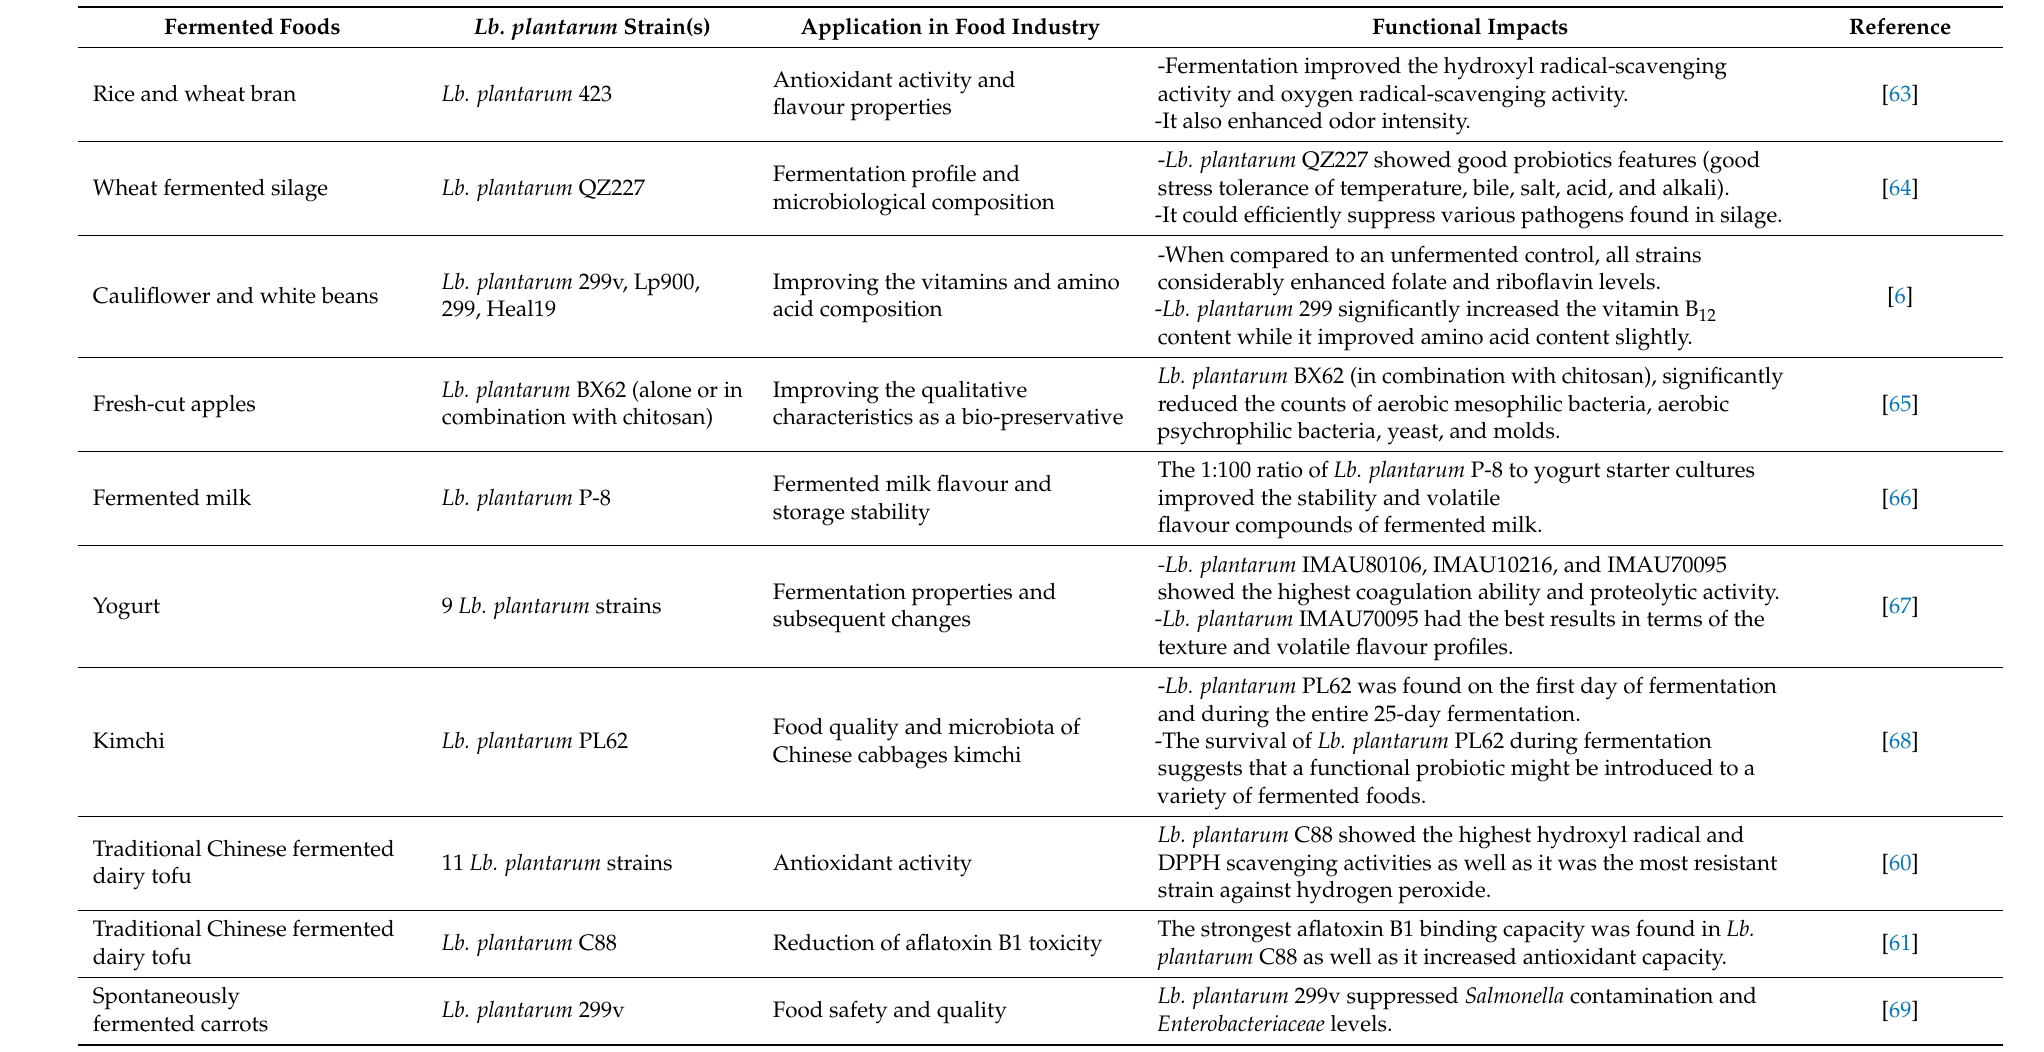
Table 1. Functional properties of Lactiplantibacillus plantarum in fermented